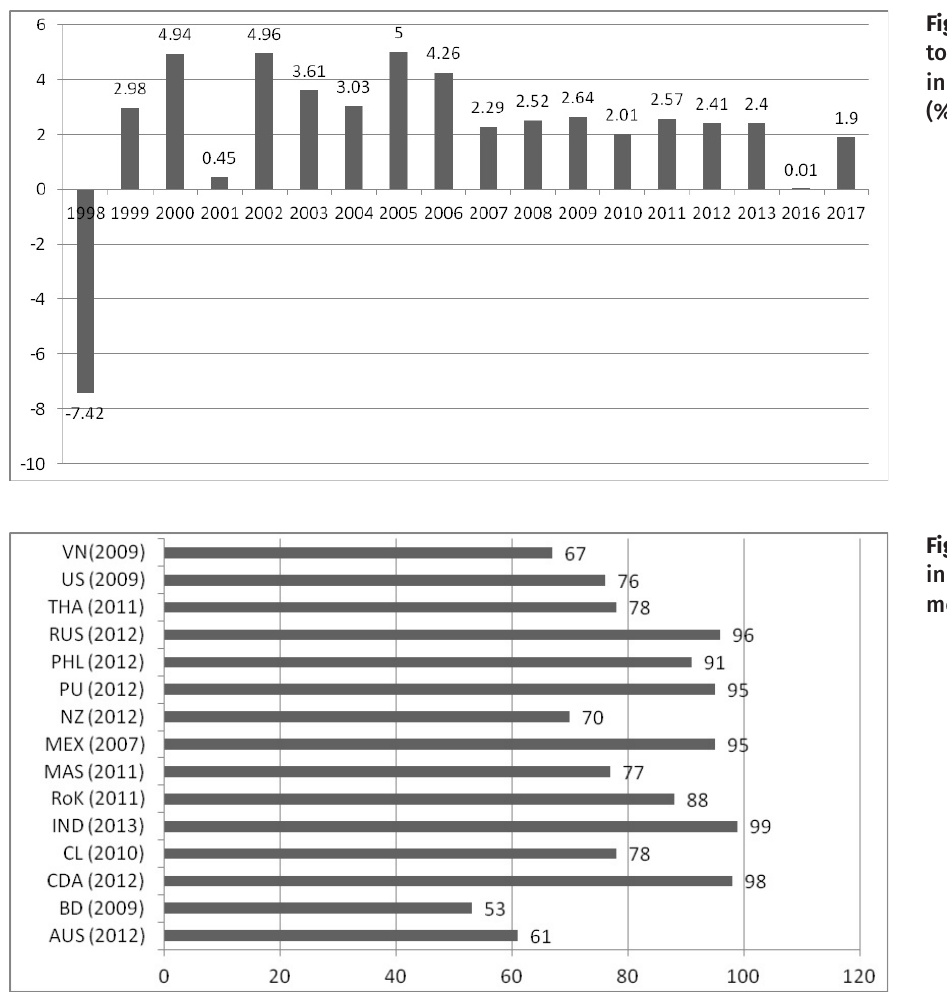
Figure 2. Growth rate of total number of MSMEs